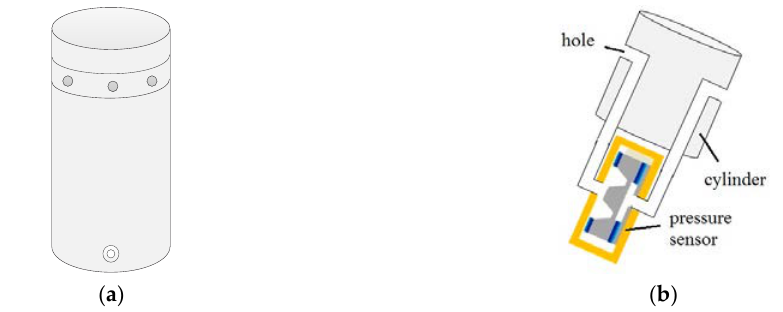
Figure 6. The prototype of the wind sensor. ( a ) Prototype of the wind sensor; ( b ) The principle of measurement.